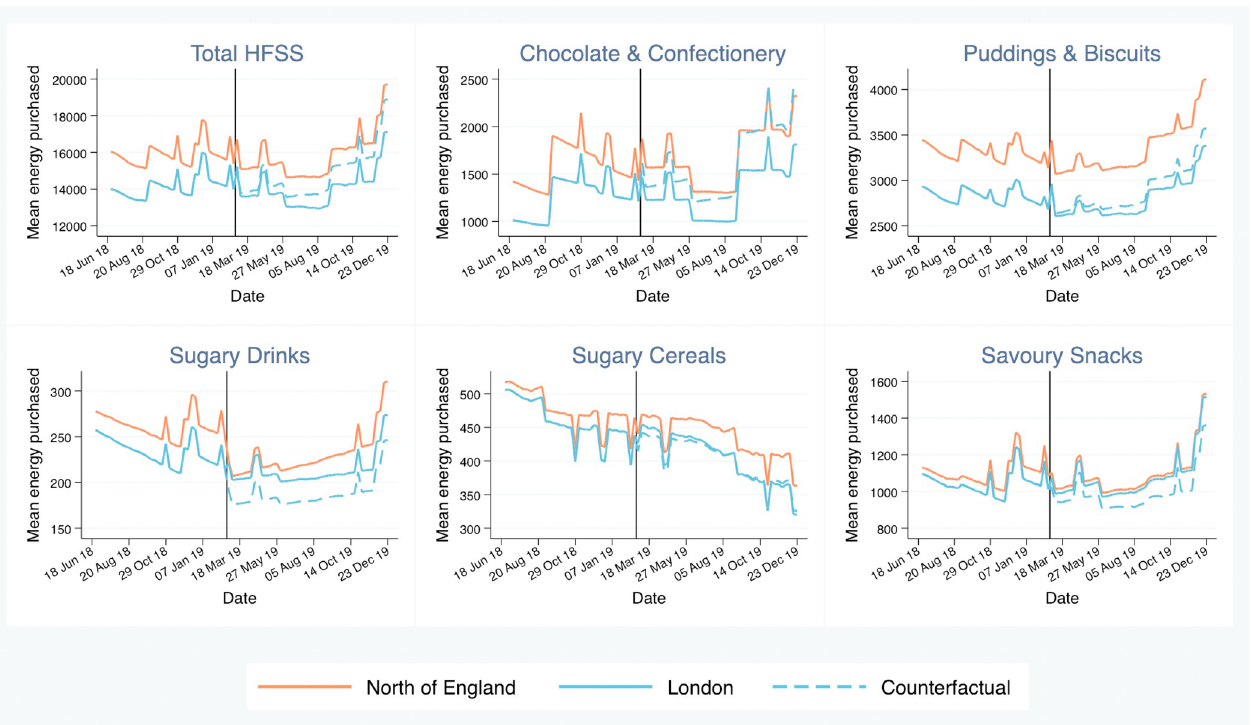
Fig 3. Adjusted weekly household mean energy purchased from high fat, salt, and sugar (HFSS) products in London (intervention), the North of England (control), and the counterfactual. Vertical line = date of intervention implementation. The counterfactual was estimated by extrapolating the pre- intervention trend in London and incorporating the post-intervention changes in the North of England. Weekly household mean energy purchased from HFSS products was estimated from a controlled interrupted time series 2-part model: part 1 (logit) and part 2 (generalised linear model) with gamma distribution. Models were adjusted for festivals, season, number of adults in household, number of children in household, and sex, age, and socioeconomic position of main food shopper. Cluster-robust standard errors were used. Household-week observations where households did not report any food and drink purchases that week were dropped. Data period = 18 June 2018 to 29 December 2019. Spikes represent festival weeks included in the models.